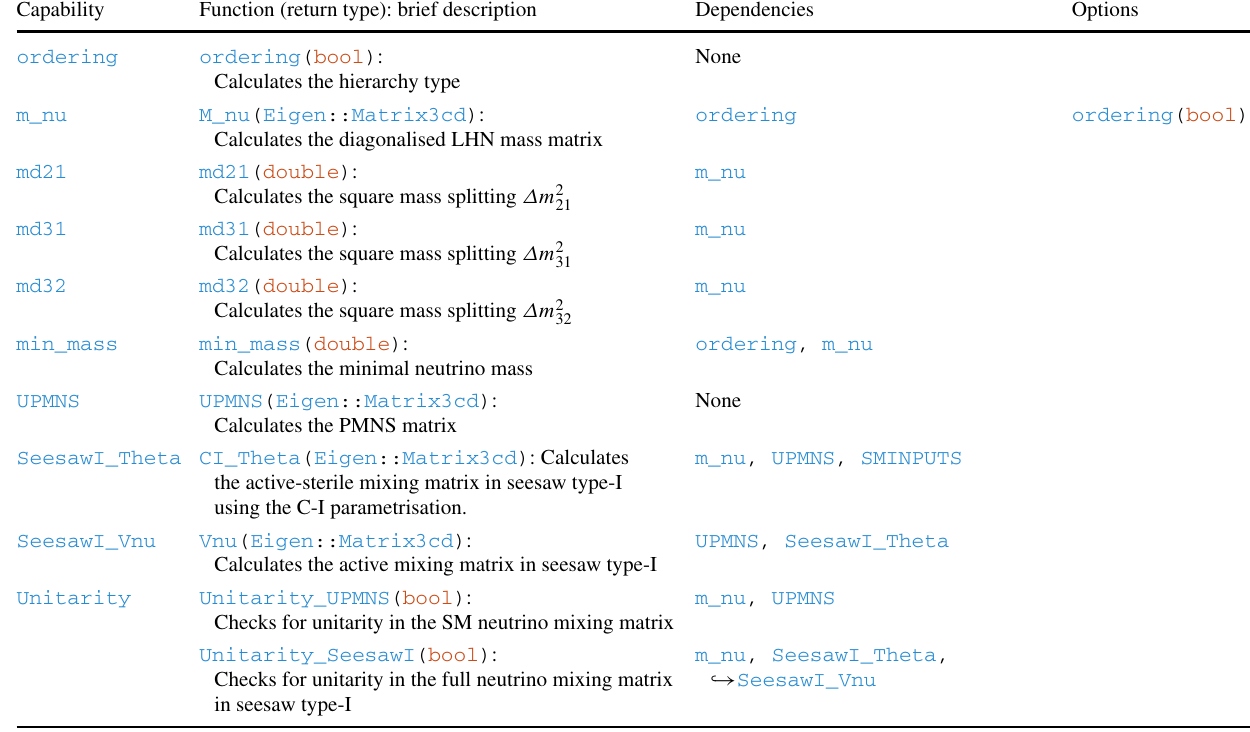
Table 8 Capabilities and module functions implemented for active and sterile neutrino masses and mixings